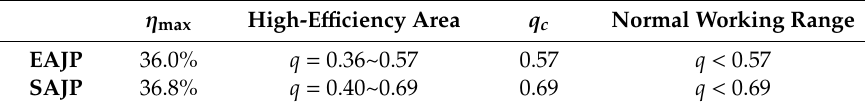
Figure 7. Wall pressure distribution.